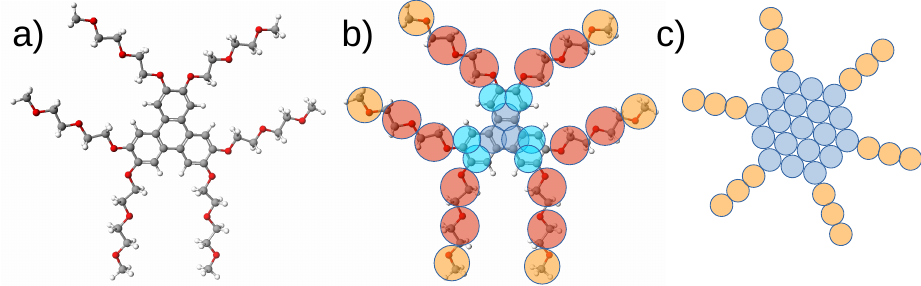
Figure 8. The nonionic chromonic mesogen TP6EO2M represented by three different levels of models. ( a ) All-atom model ( b ) a MARTINI-style coarse-grained model, and ( c ) a simple dissipative particle dynamics model. For coarse-grained models, bonds (not shown) link adjacent sites and angle interactions help to define molecular shape, blue beads represent different hydrophobic sites, and red and orange beads represent hydrophilic